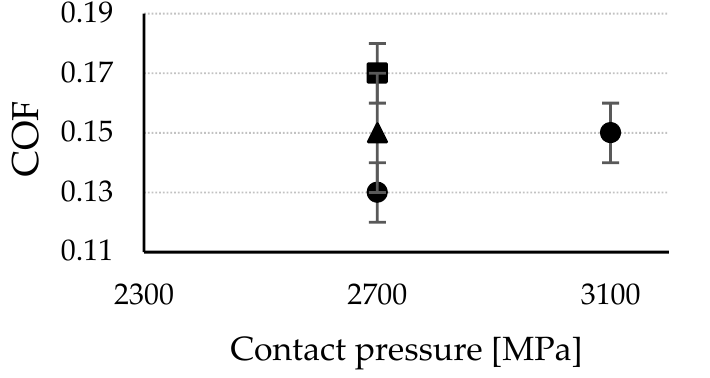
Figure 4. COF at different contact pressures.